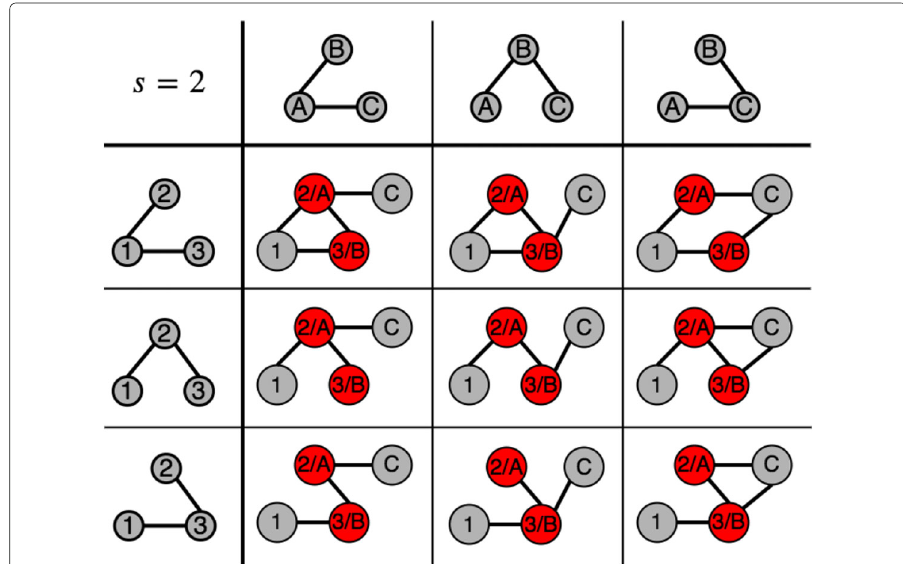
Fig. 1 Super-motifs resulting from the overlapping between all NRPs of the non-induced 3-nodes path with s = 2 nodes. Results are shown in a matrix fashion, where the entry at row i and column j is the super-motif originating from the NRP at the i -th row and the NRP at the j -th columnn. Nodes of each super-motif contain node ids of the starting NRPs. Nodes in the overlapping region are colored in